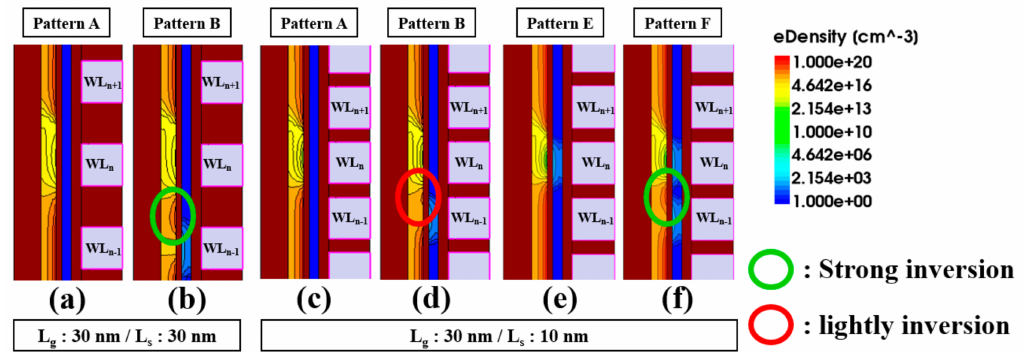
Figure 4. Simulation result of electron density contour at the turn-on state of the selected cell during the read operation of the 3D NAND flash memory in each pattern. ( a ) Gate and space length 30 nm at pattern A, ( b ) gate length 30 nm, space length 30 nm at pattern B, ( c ) gate length 30 nm, space length 10 nm at pattern A, ( d ) gate length 30 nm, space length 10 nm at pattern B, ( e ) gate length 30 nm, space length 10 nm at pattern E, ( f ) gate length 30 nm, space length 10 nm at pattern